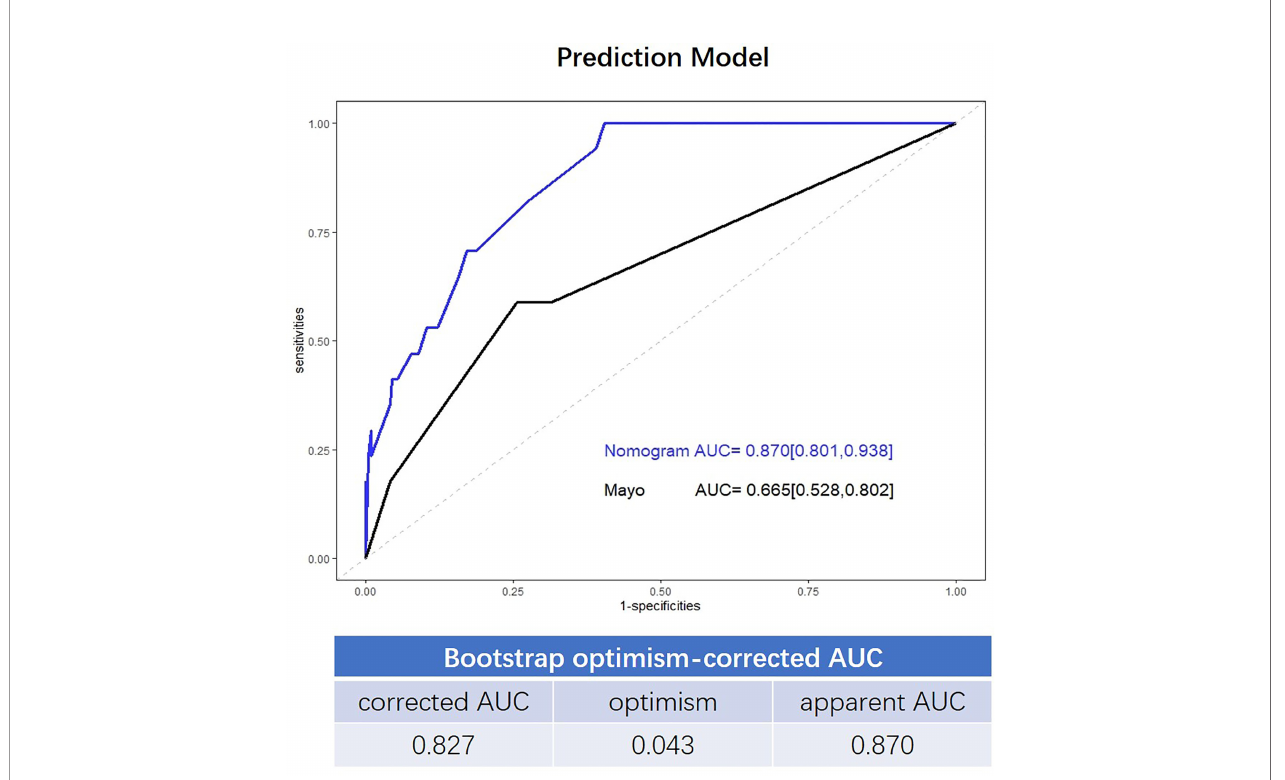
FIGURE 2 | Receiver operating characteristic (ROC) curve showing the performance of the Mayo criteria and novel model.